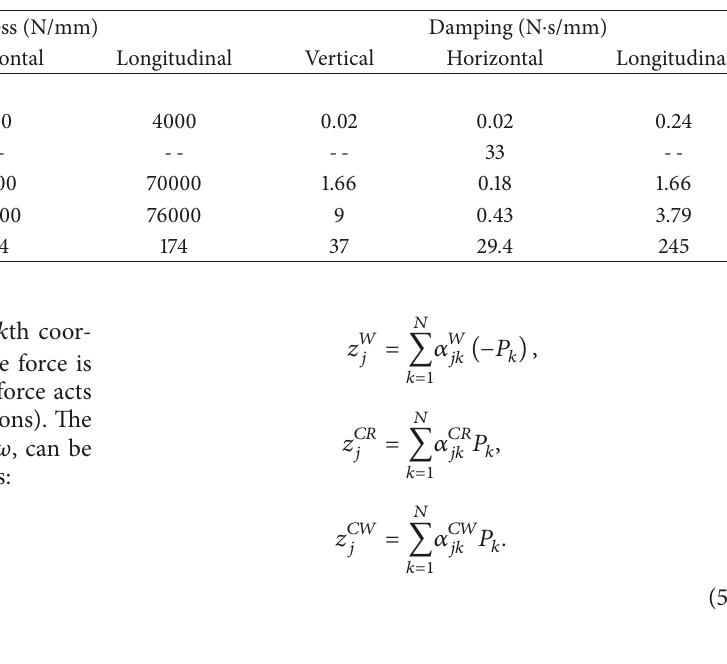
Table 1: Values of stiffness and damping involved in this